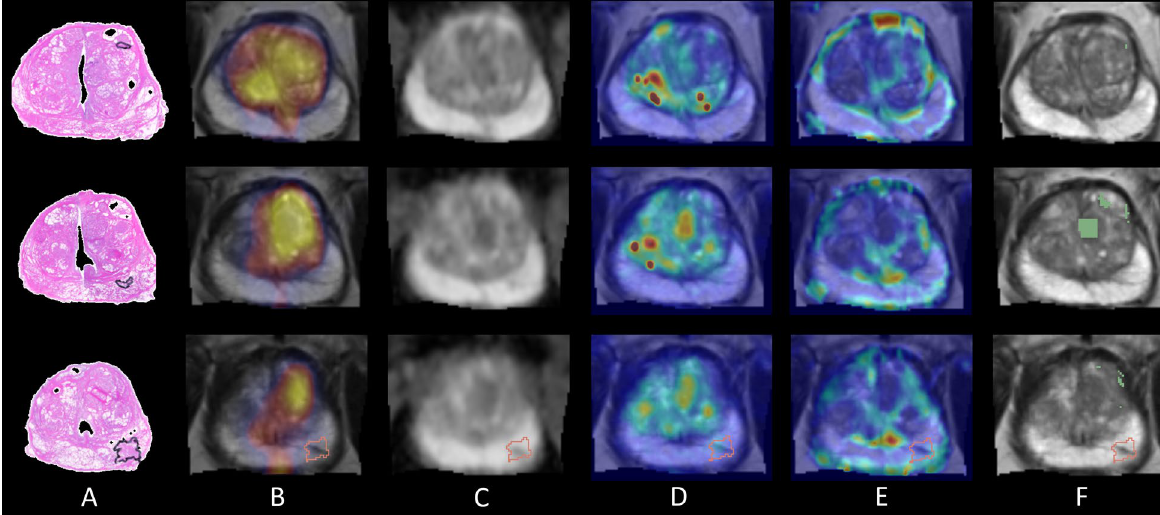
Fig. 5 Results from the worst performing patient 60 showing three histology slices out of six, which had tumour visible, from top to bottom (mid-gland to apex) with: a tumour annotations on histology, b PET and T2w MRI, c the ADC map, d Ktrans map, e TTP map and f the predicted tumour voxels in green overlaid on the T2w MRI, each visualised with the tumour location outline from histology